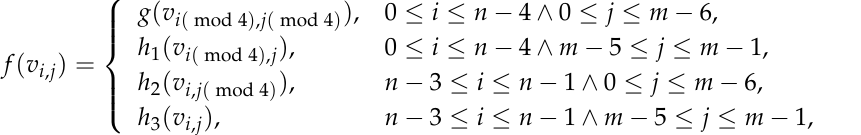
n (cid:50) C 5 for n ≡ 2 ( mod 4 )